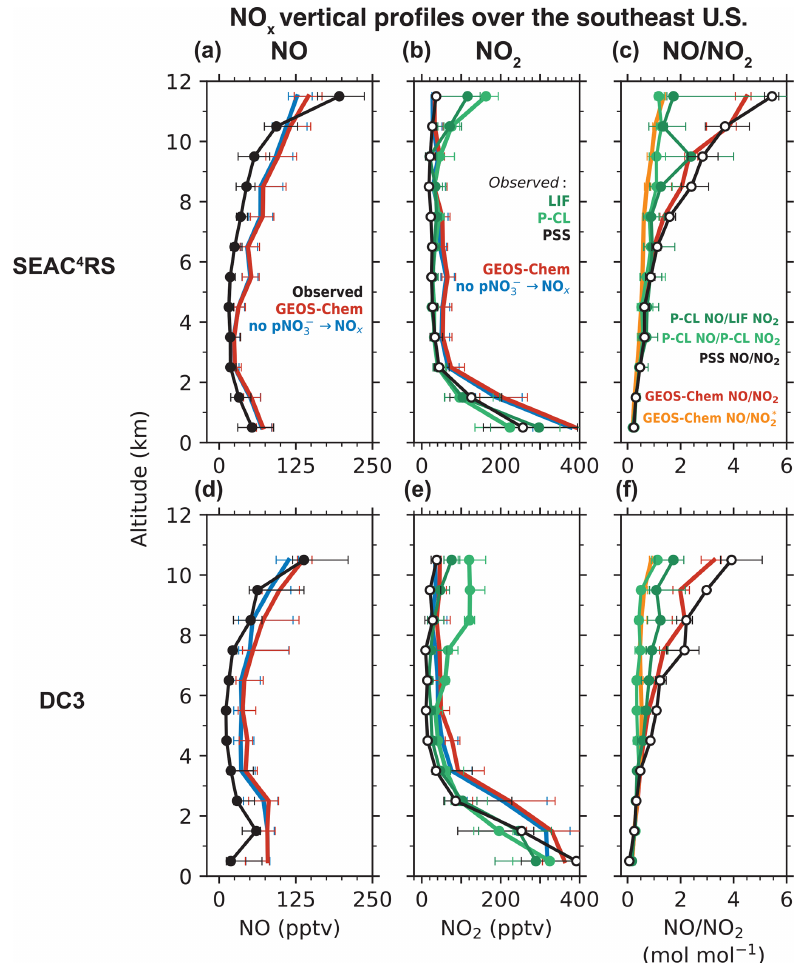
Figure 1. Median vertical profiles of observed and GEOS-Chem simulated NO concentrations (a, d) , NO 2 concentrations (b, e) , and NO / NO 2 molar ratios (c, f) during the SEAC 4 RS (August–September 2013) and DC3 (April–May 2012) aircraft campaigns over the southeastern U.S. The NO measurements are from the NOAA P-CL instrument. NO 2 was measured by the Berkeley LIF and the NOAA P-CL instruments. The NO / NO 2 ratios at the photochemical steady state (PSS; Eq. 2) and the corresponding NO 2 concentrations (Eq. 3) are also shown in panels (c) and (f) . The PSS calculation is based mostly on observed quantities but uses modeled values for quantities that were not measured, as described in the text. Also shown in panels (c) and (f) are the NO / NO ∗ GEOS-Chem. MPN is methyl peroxy nitrate. We exclude measurements in early mornings and late evenings (solar zenith angle > 70 ◦ ) and those influenced by fresh NO x emissions recent convection, biomass burning, and the stratosphere, as described in Sect. 2.1. The horizontal bars show the interquartile ranges of the measurements in each 1km altitude